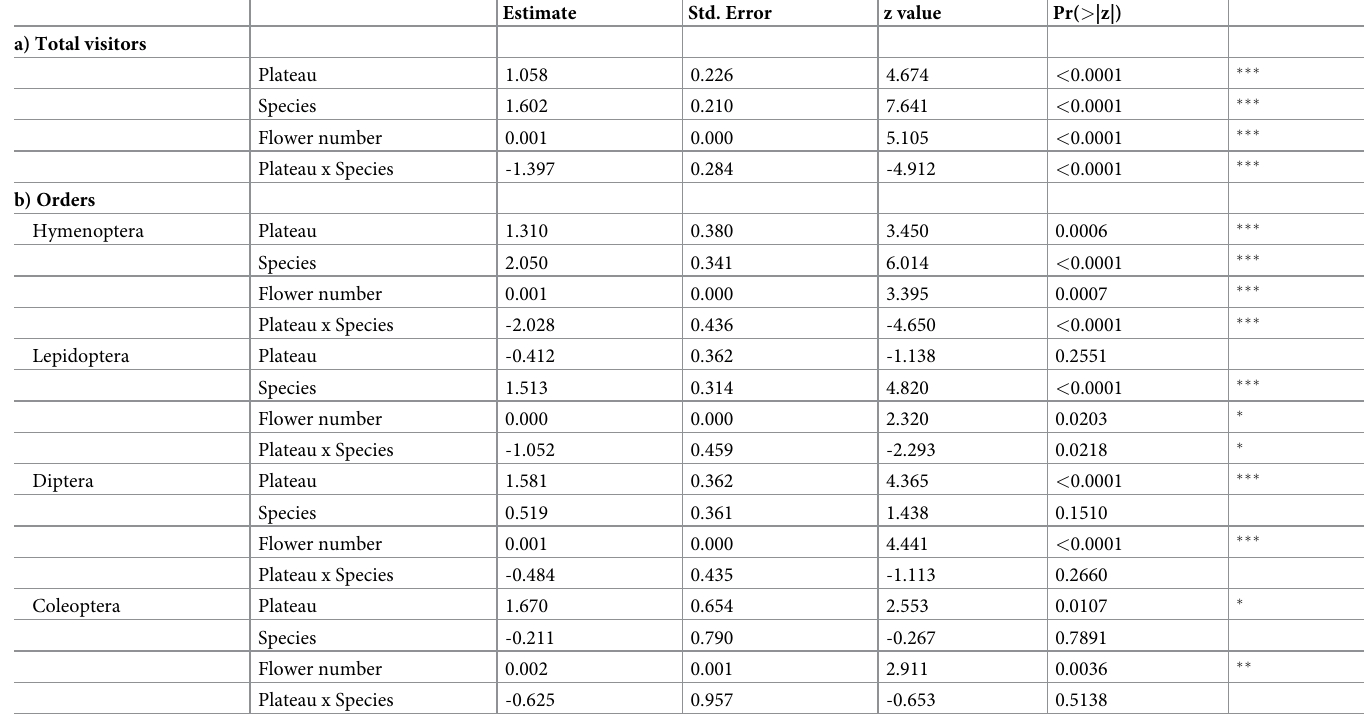
Table 2. Variation in floral visitation rates to the Impatiens species. Summary statistics for the effect of plateau and species (fixed variables) and flower number (ran- dom variable) are presented.